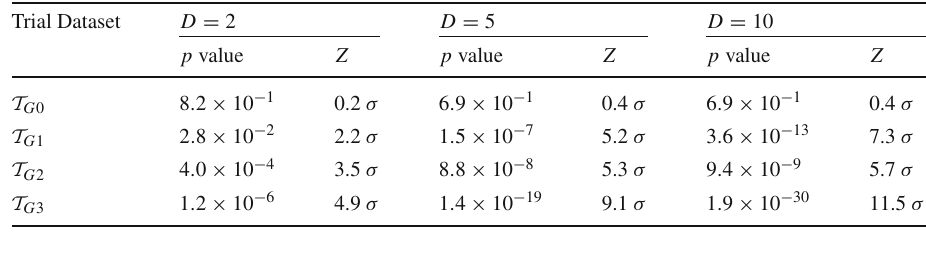
Table 4 Summary of the results comparing B with 4 trial samples, for different dimensionality D . The samples are defined in Table 3. We set K = 5 and N perm = 1000